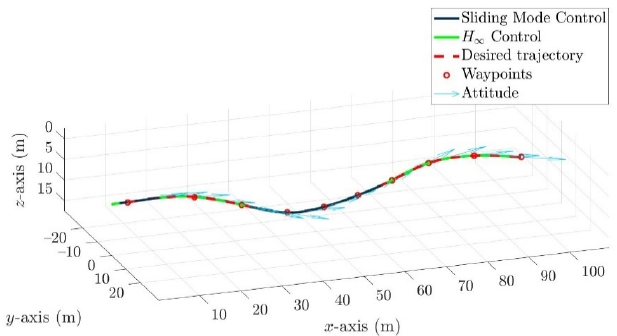
Figure 11. Trajectory tracking history of the controlled torpedo-like underwater vehicle based on sliding mode control law (blue line) and the proposed nonlinear H ∞ control law (green line) for Scenario 1.